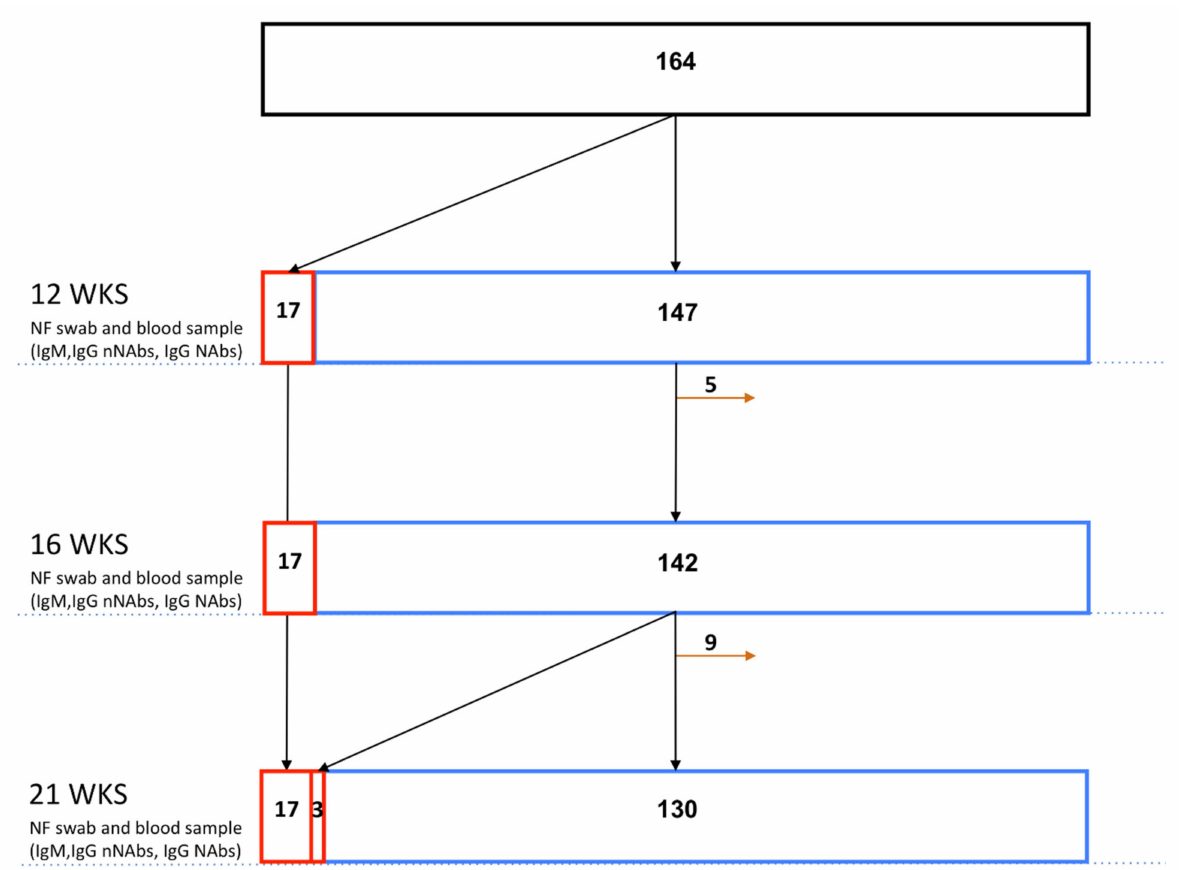
Figure 3. Study flow diagram: case ascertainment and control selection. nNAbs, non-neutralizing antibodies; NAbs, neutralizing antibodies; NF, nasopharyngeal; orange arrow, patients excluded; WKS, weeks of gestation.